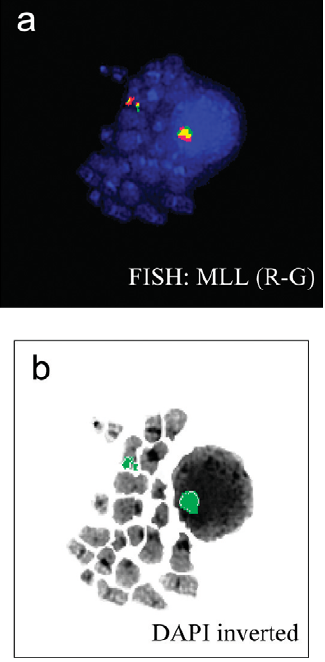
Fig. 4. A special form of biphasic nucleus with one set of chromo- somes at metaphase while the other set remained lagging at inter- phase. Such “ harlequin ” nuclei were described earlier as partial Pre- maturely Condensed Chromosomes (PCC). Note the red–green sig- nal of the fusion probe MLL on the homologues of chromosome HSA 11 (panel (a)). Panel (b) shows the inverted DAPI image of the “ harlequin ” nucleus revealing its half meta- and half interphase